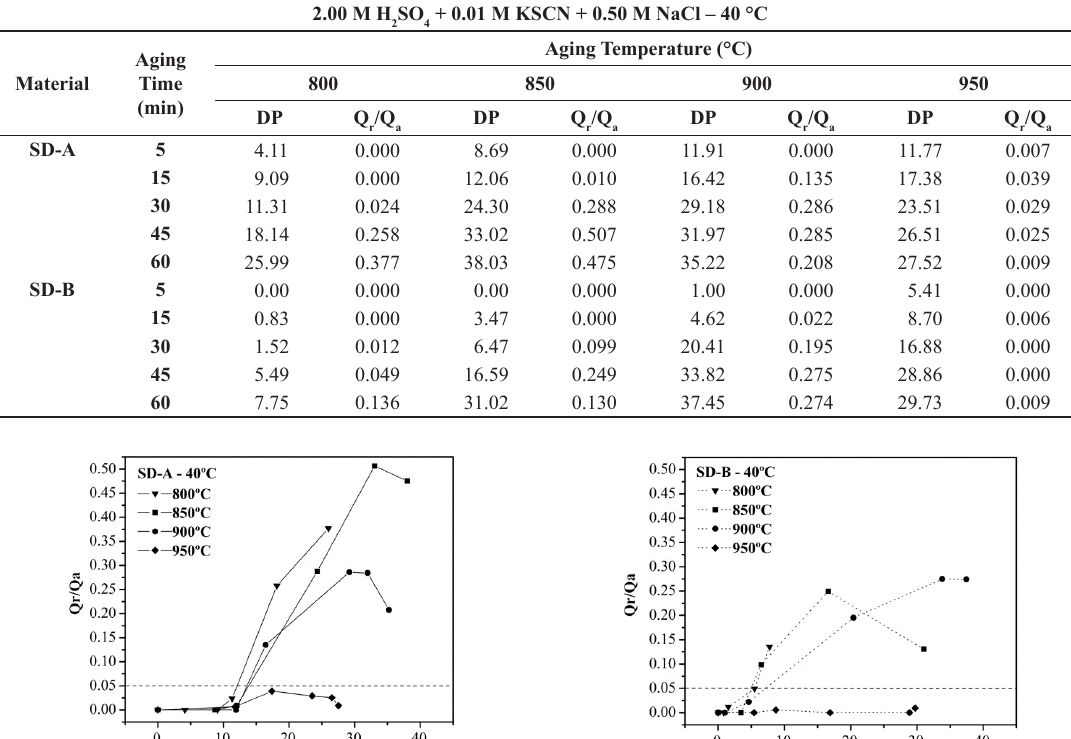
SO + 0.01 M KSCN 2 4